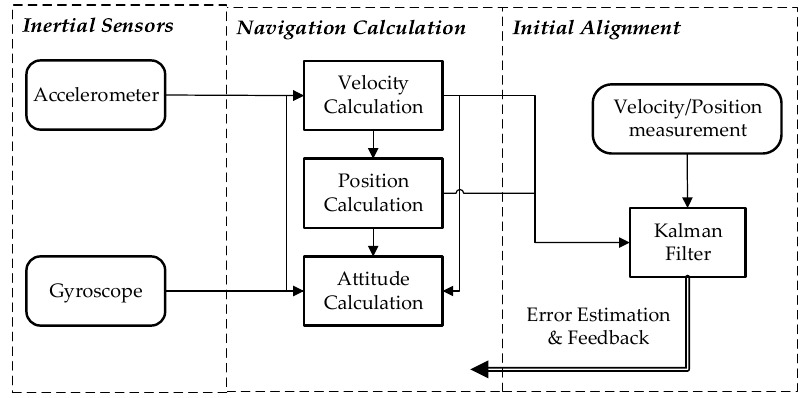
Figure 5. The schematic of inertial navigation.